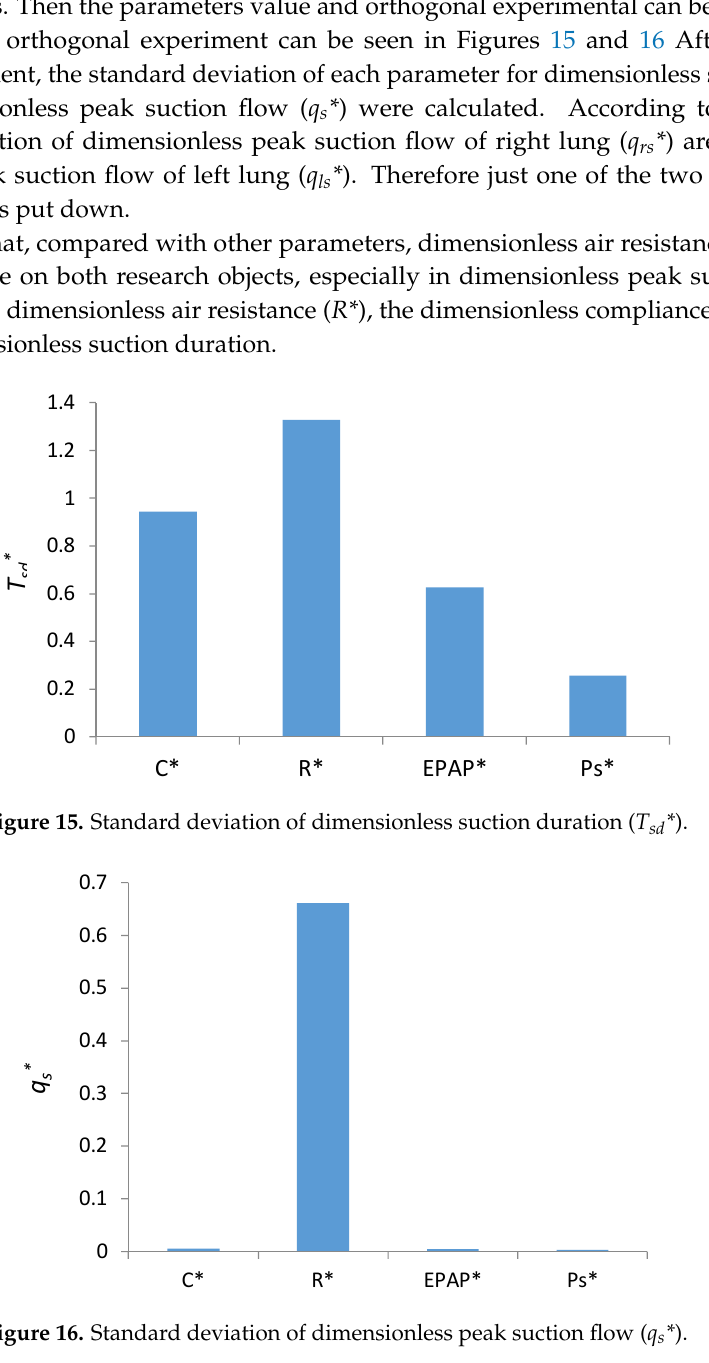
Figure 16. Standard deviation of dimensionless peak suction flow ( q s * ).